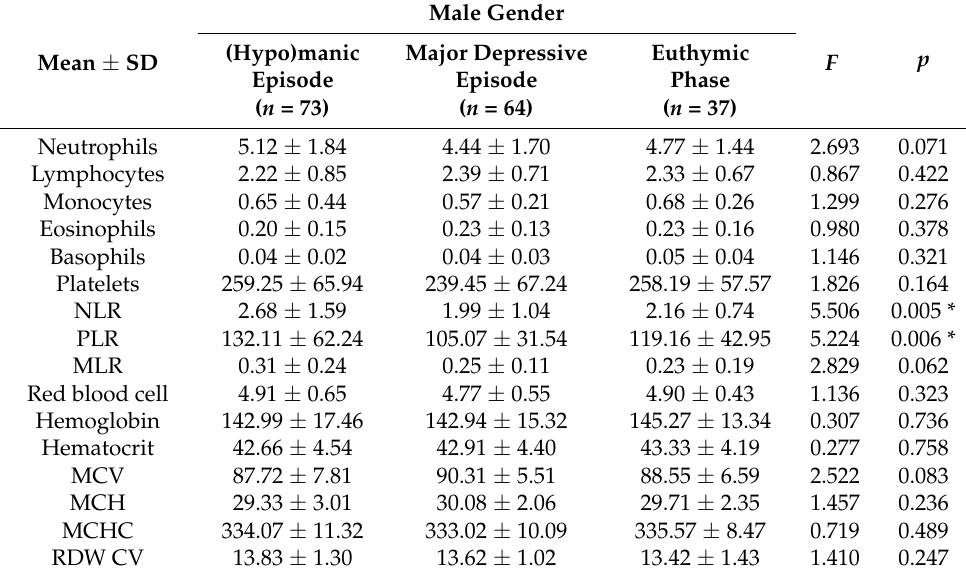
Table 2. Differences in complete blood count and inflammatory ratios in bipolar males, according to illness phase.